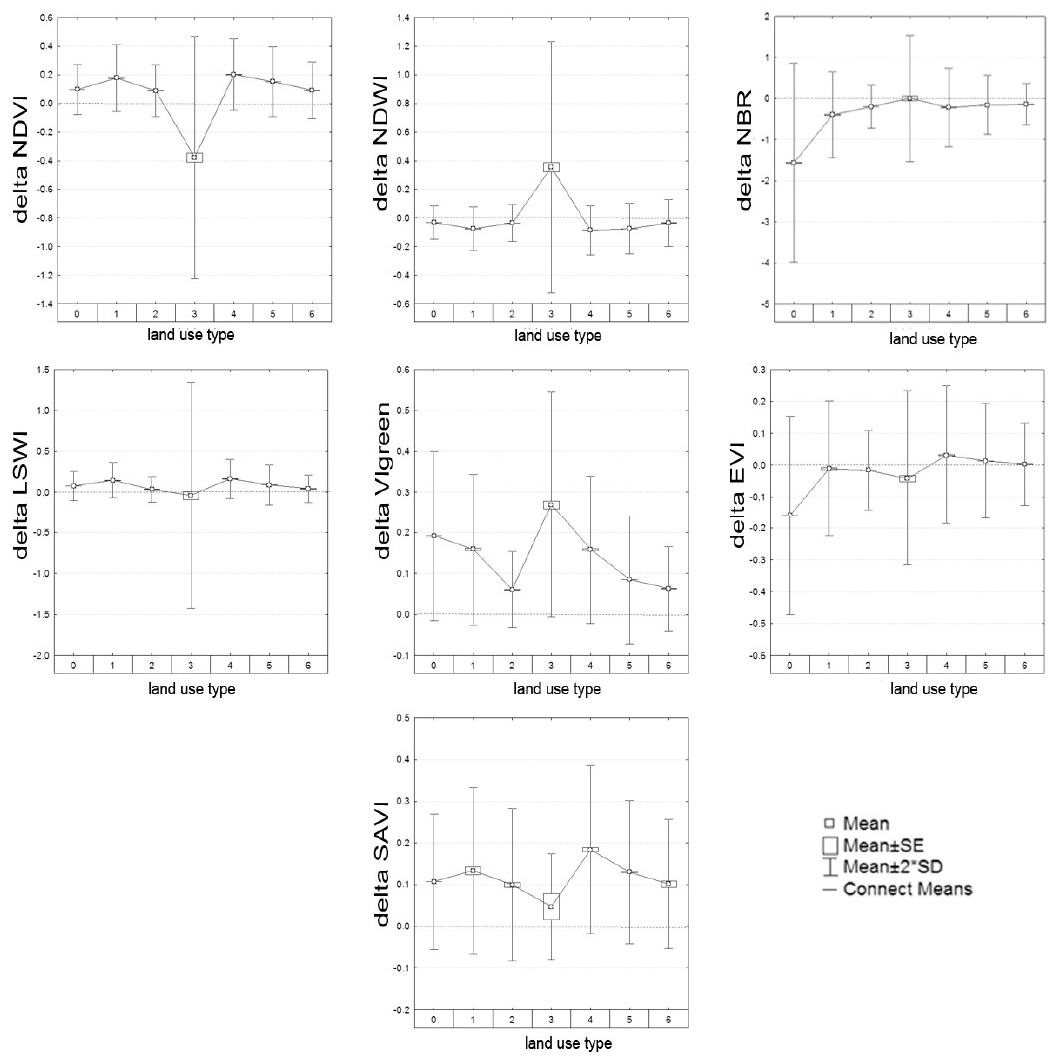
Figure 5. OLI and ETM+ based vegetation indices differences Box foreland use classes (0 = forests; 1 = Mixed agricultural areas; 2 = Tree crops; 3 = Water bodies; 4 = Pastures and grasslands; 5 = Arable lands; 6 = Urbanized areas).